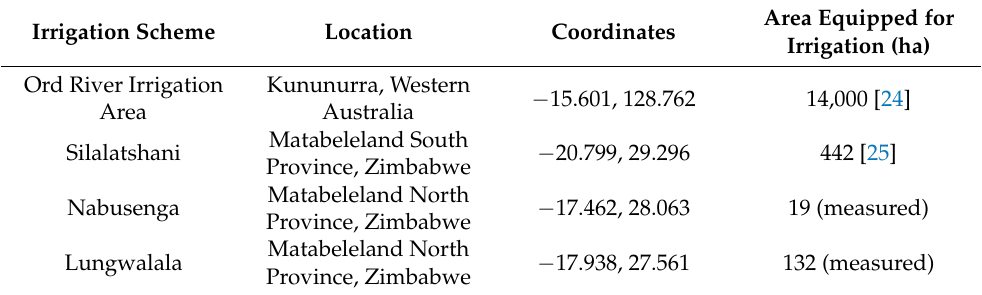
Table 1. Irrigation schemes used for irrigated land use classification, their location, coordinates, and approximate